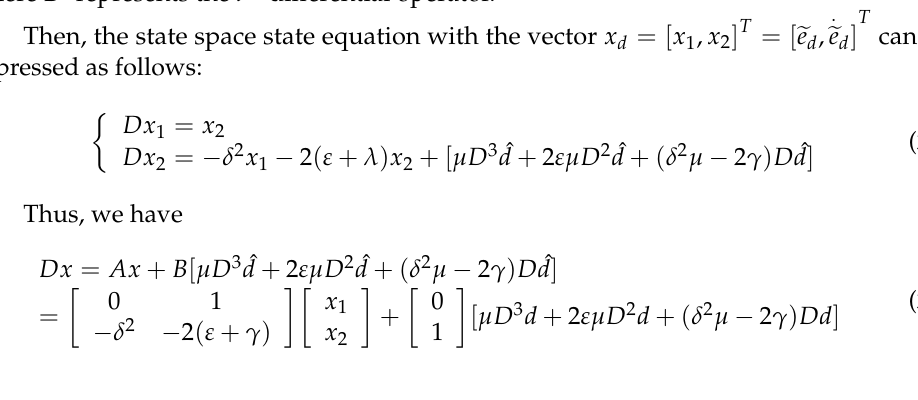
Figure 3. Bode diagram of